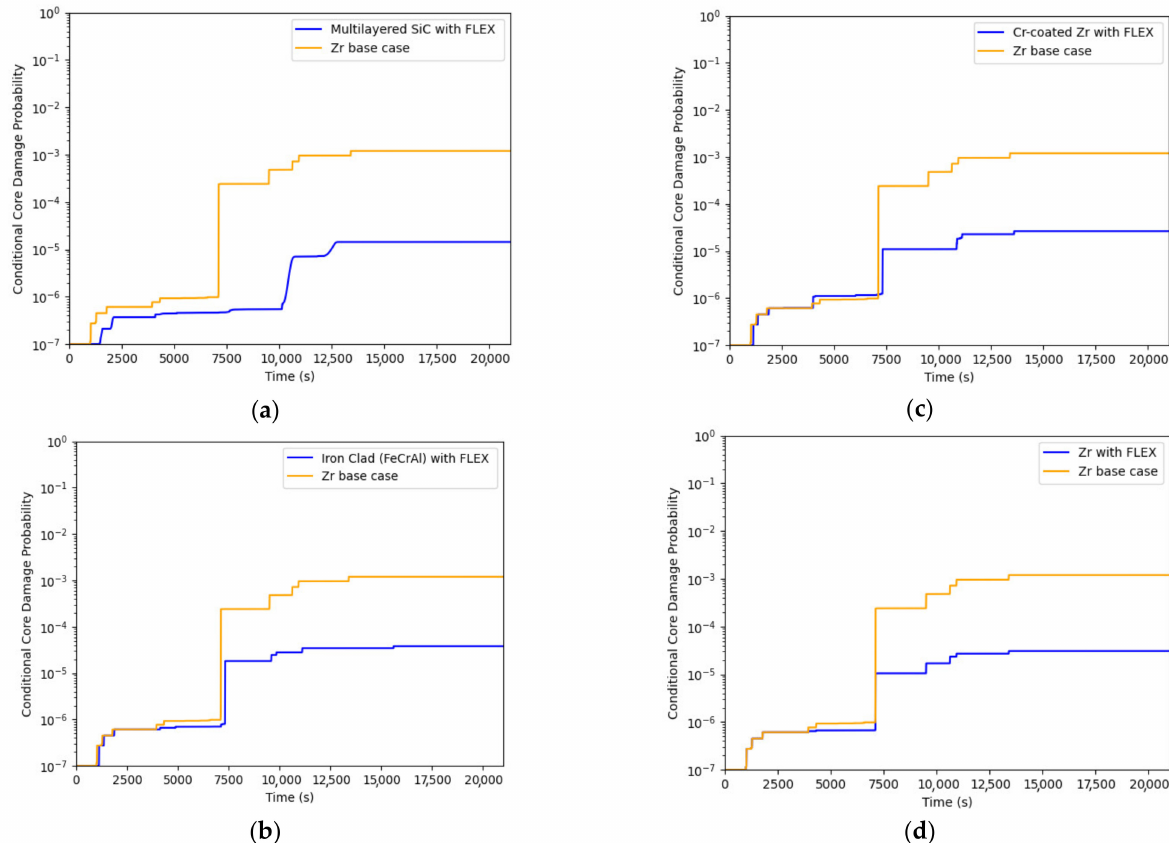
Figure 13. Overall conditional core damage probabilities with FLEX for fuel candidates: ( a ) Multi-layered SiC; ( b ) Iron-clad (FeCrAl); ( c ) Chromium-coated Zircaloy (Cr-coated Zr); ( d ) Conventional Zircaloy